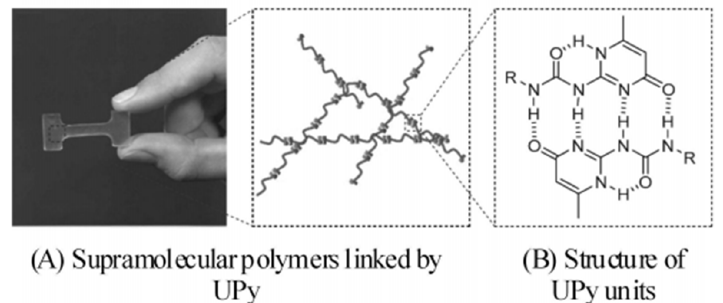
Figure 3. Zooming in on supramolecular polymers linked by UPy. (Reprinted (adapted) with per- mission from [41]. Copyright [41] American Chemical Society).